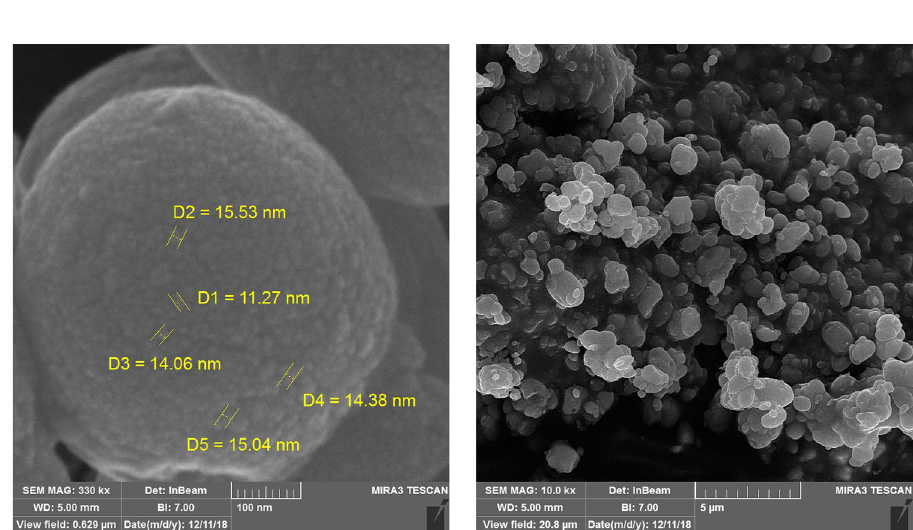
Figure 4. Scanning electron microscope (SEM) images of Fe 3 O 4 @Co(BDC)-NH 2